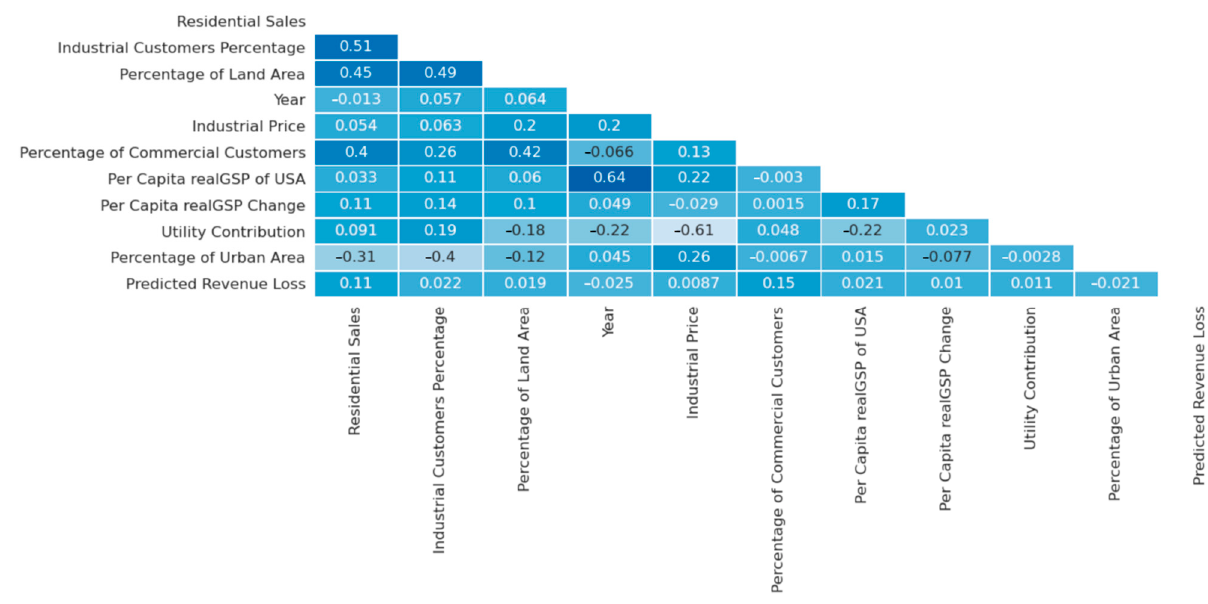
Figure 18. Heat map of Pearson correlation coefficients among top 10 important features.